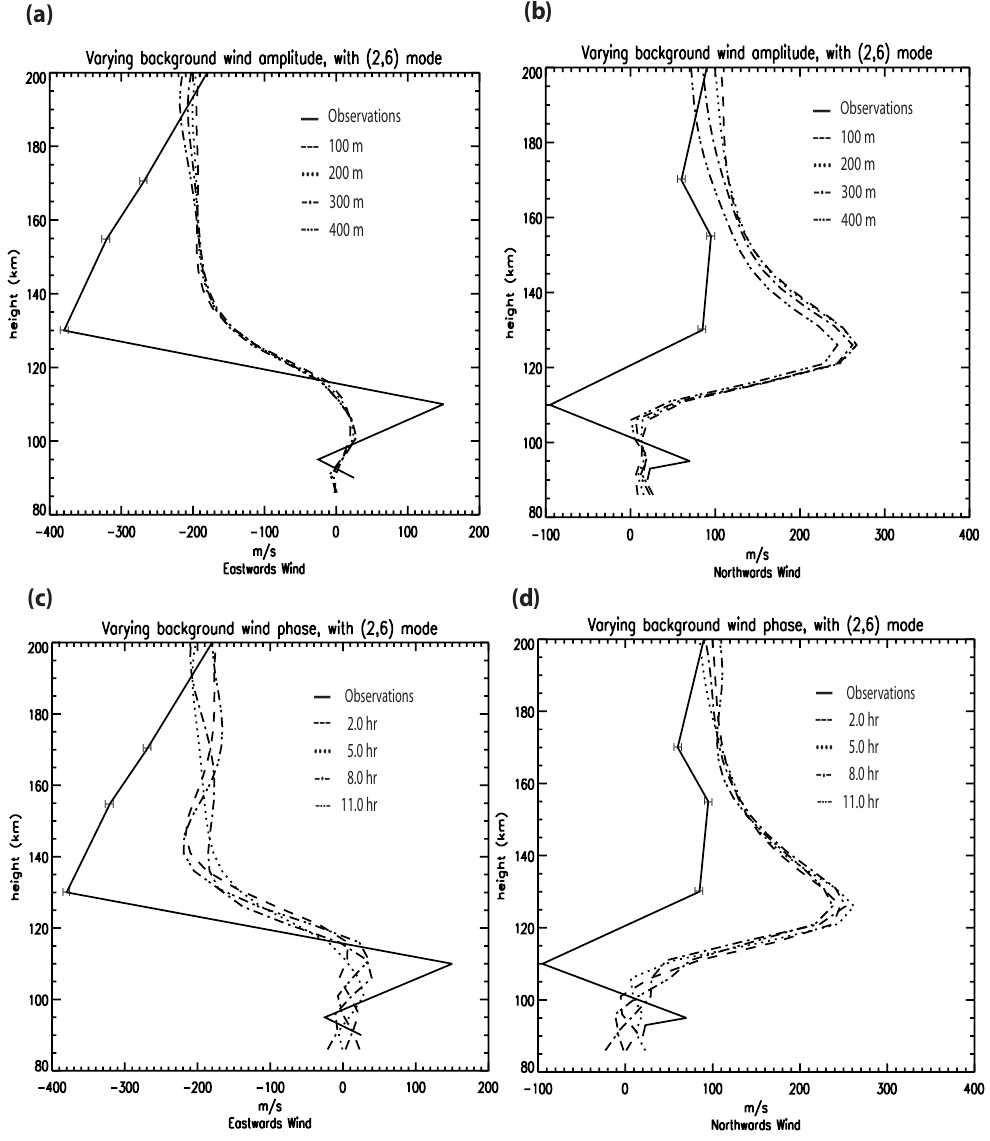
Fig. 7. As Fig. 6, but for the northern trail 28 February dusk side